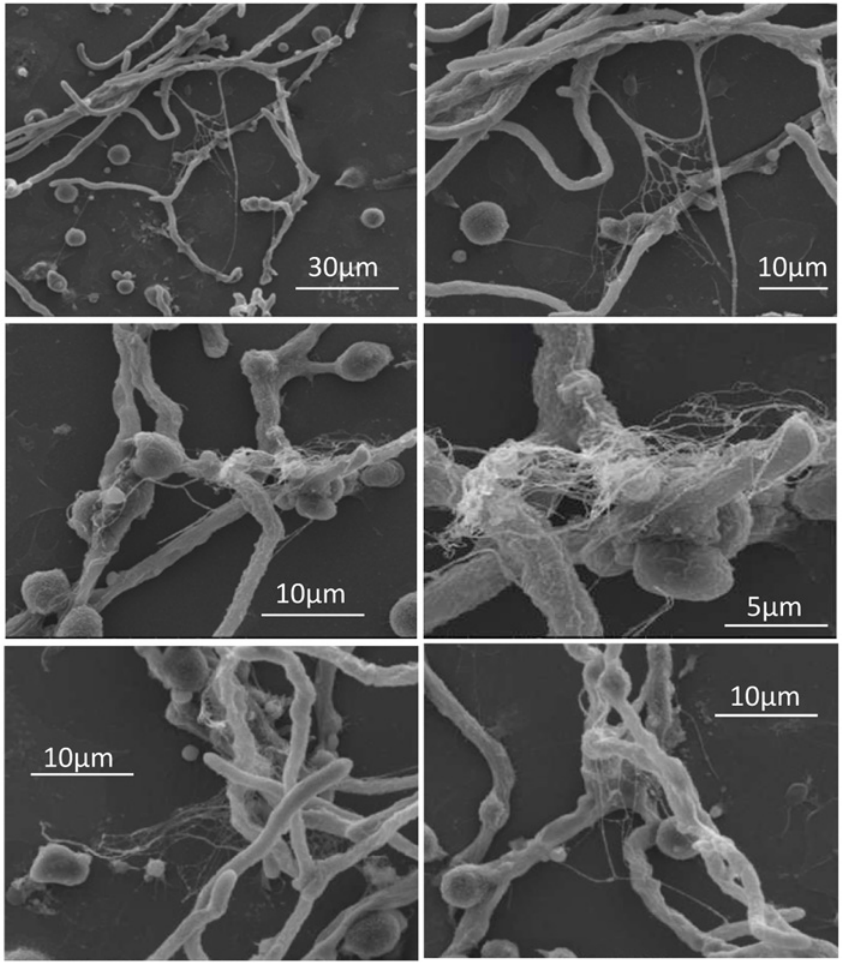
Fig 5. Scanning electron microscopy of pDCs incubated with A . fumigatus hyphae. Human pDCs (2 × 10 5 /well) were stimulated for 4 hr with A. fumigatus hyphae (4 × 10 5 ). The samples were then fixed and imaged by scanning electron microscopy. Areas with pETs are shown at low (left panels) and high (right panels) magnification. The data are representative of two independent